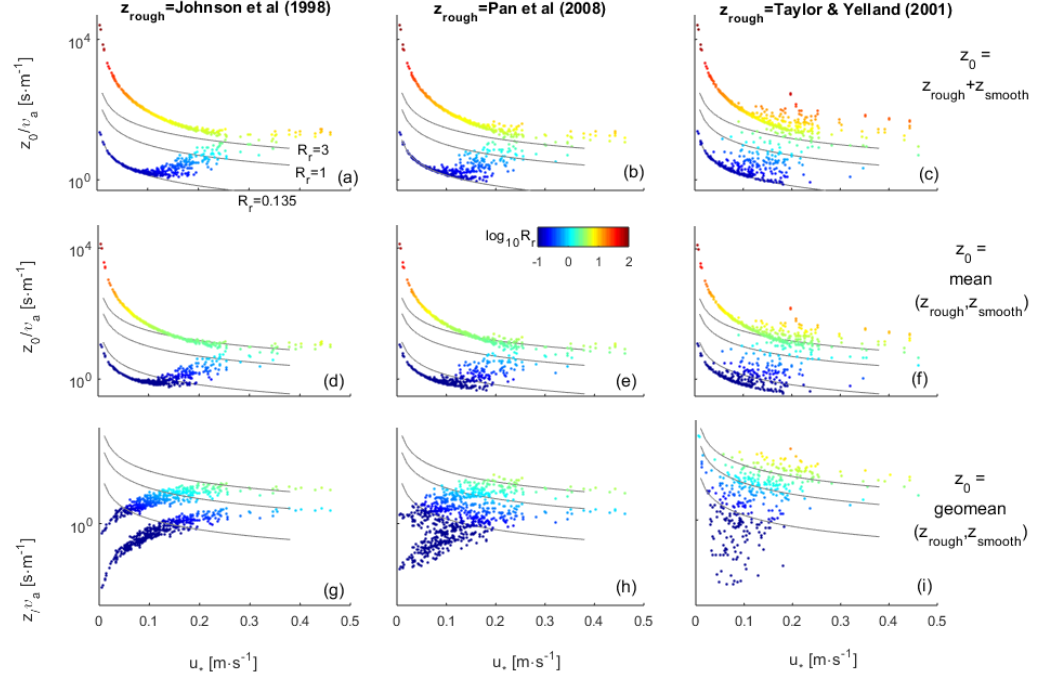
Figure 4. Definite estimation of roughness length (z 0 ) congregating the smooth and rough air-flow regimes. Congregation of z smooth and z rough was additive ( a – c ), their arithmetic mean ( d – f ) or their geometric mean ( g – i ). Roughness length under rough air-flow (z rough ) was estimated from the formulations by Johnson et al. [98] [Equations (7) and (8)], Pan et al. [123] [Equation (12a)] or Taylor and Yelland [110] [Equation (11a)]. Roughness length under smooth air-flow (z smooth ) was estimated from the formulation by Wu [35,62] [Equation (14)] (upper trajectories with larger R r ) or formulations relying on a fixed R r (bottom trajectories closer to the R r = 0.135 threshold). In bottom-right panel is only shown the geometric mean between Taylor & Yelland [110] and Wu [35,62]. Roughness Reynold number estimated from R r = z 0 × u * /υ a .